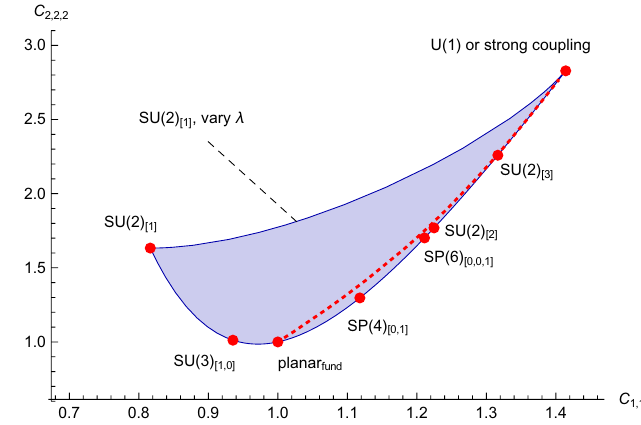
p p 2 ; 2 2) (for any